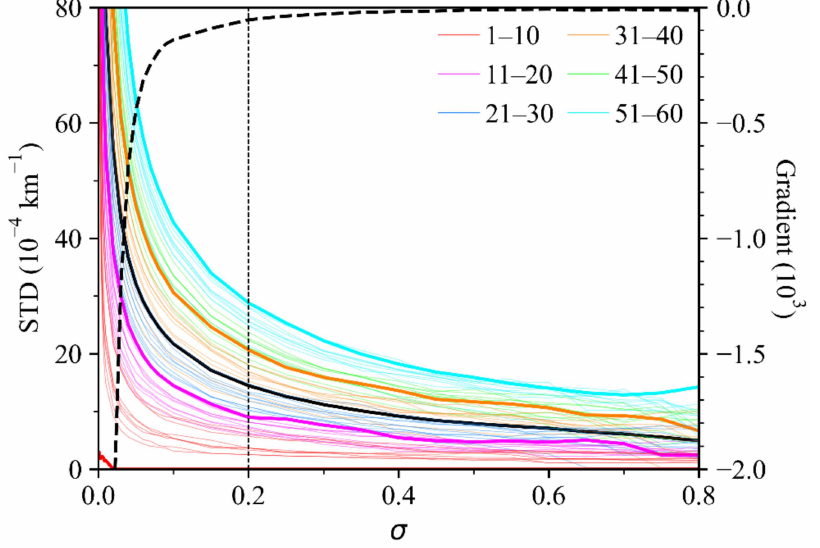
Figure 4. Variations of standard deviations (STDs) of wavenumbers whose amplitudes are greater than σ A max with respect to σ for each of PCA components 1–60 (thin solid colored curves), the average variation of the 60 STDs (thick solid black curve), and the gradient of the averaged STD (thick dotted black curve). The STD curve of the first, 20th, 40th, and 60th PCA component is indicated by the thick red, magenta, orange, and cyan curve, respectively. The chosen value of threshold at 0.2 (thin dotted black line) is also